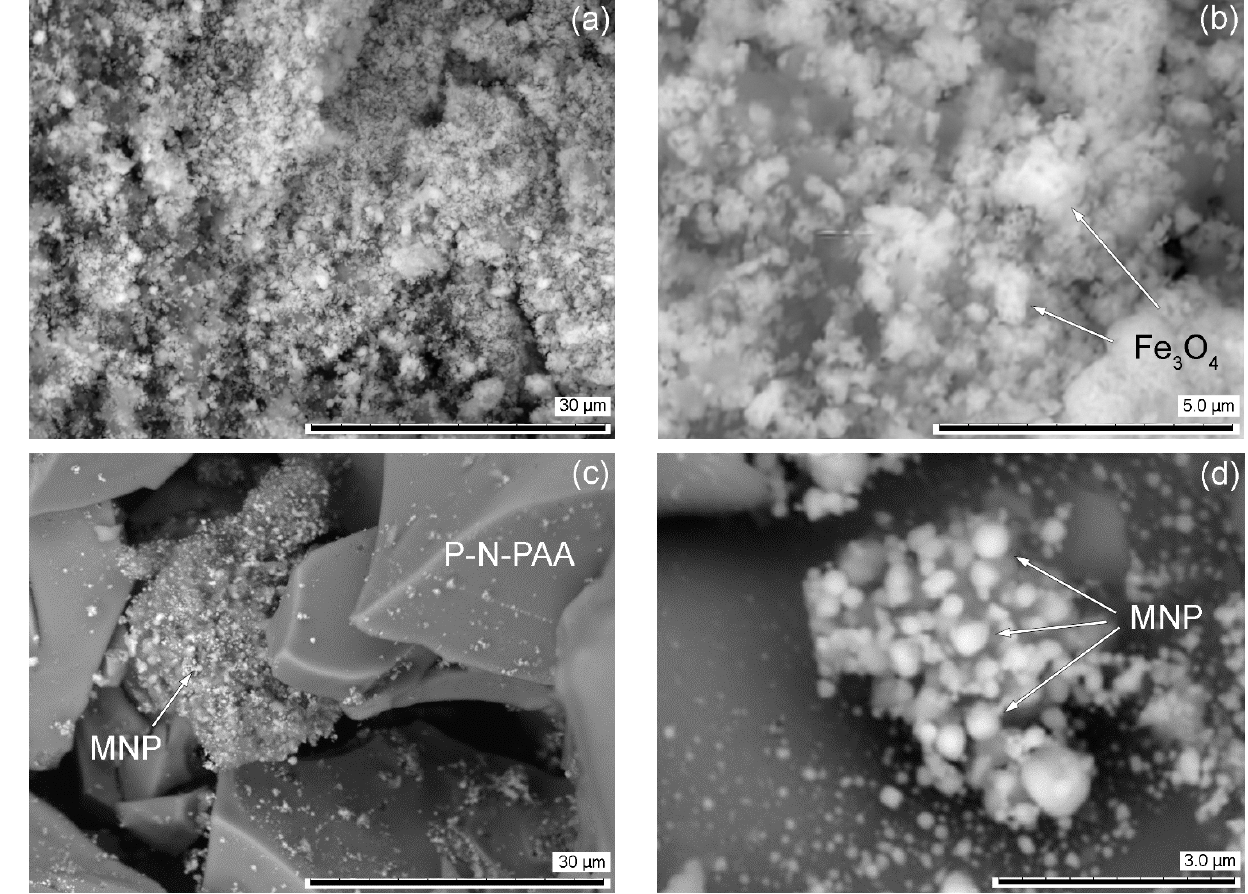
Figure 8. SEM images of Fe 3 O 4 /P ‐ N ‐ PAA ( a , b ) and MNP/P ‐ N ‐ PAA ( c , d ).